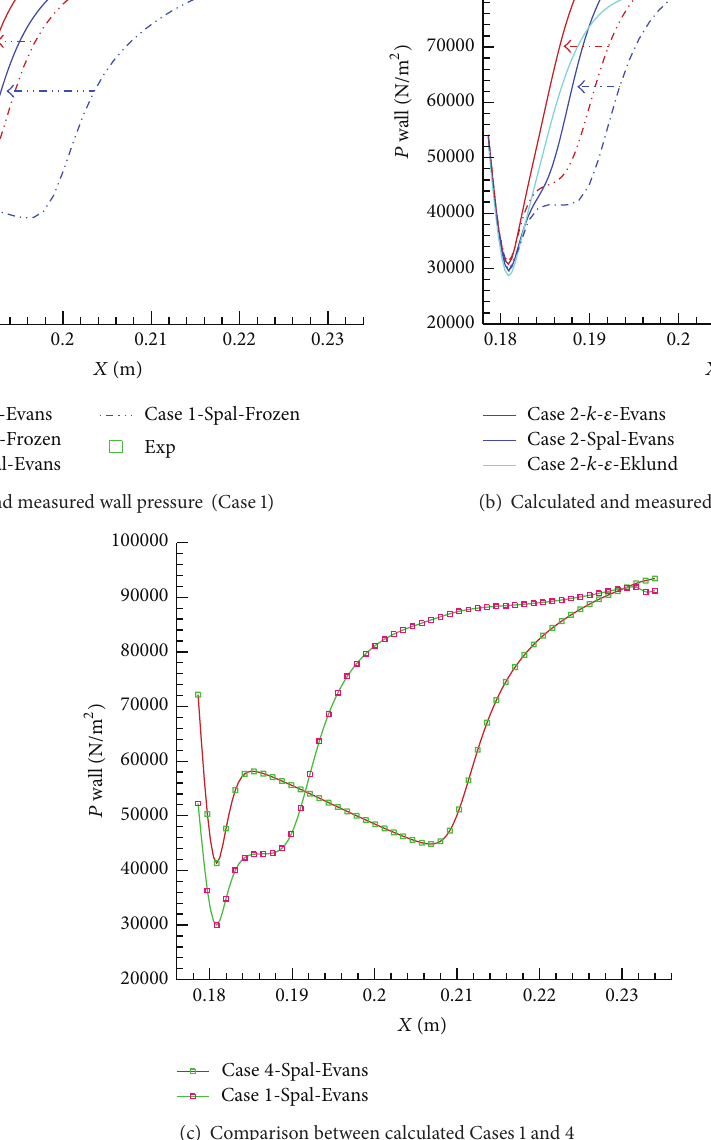
Figure 7: Calculated and measured wall pressure in the zone downstream the injection